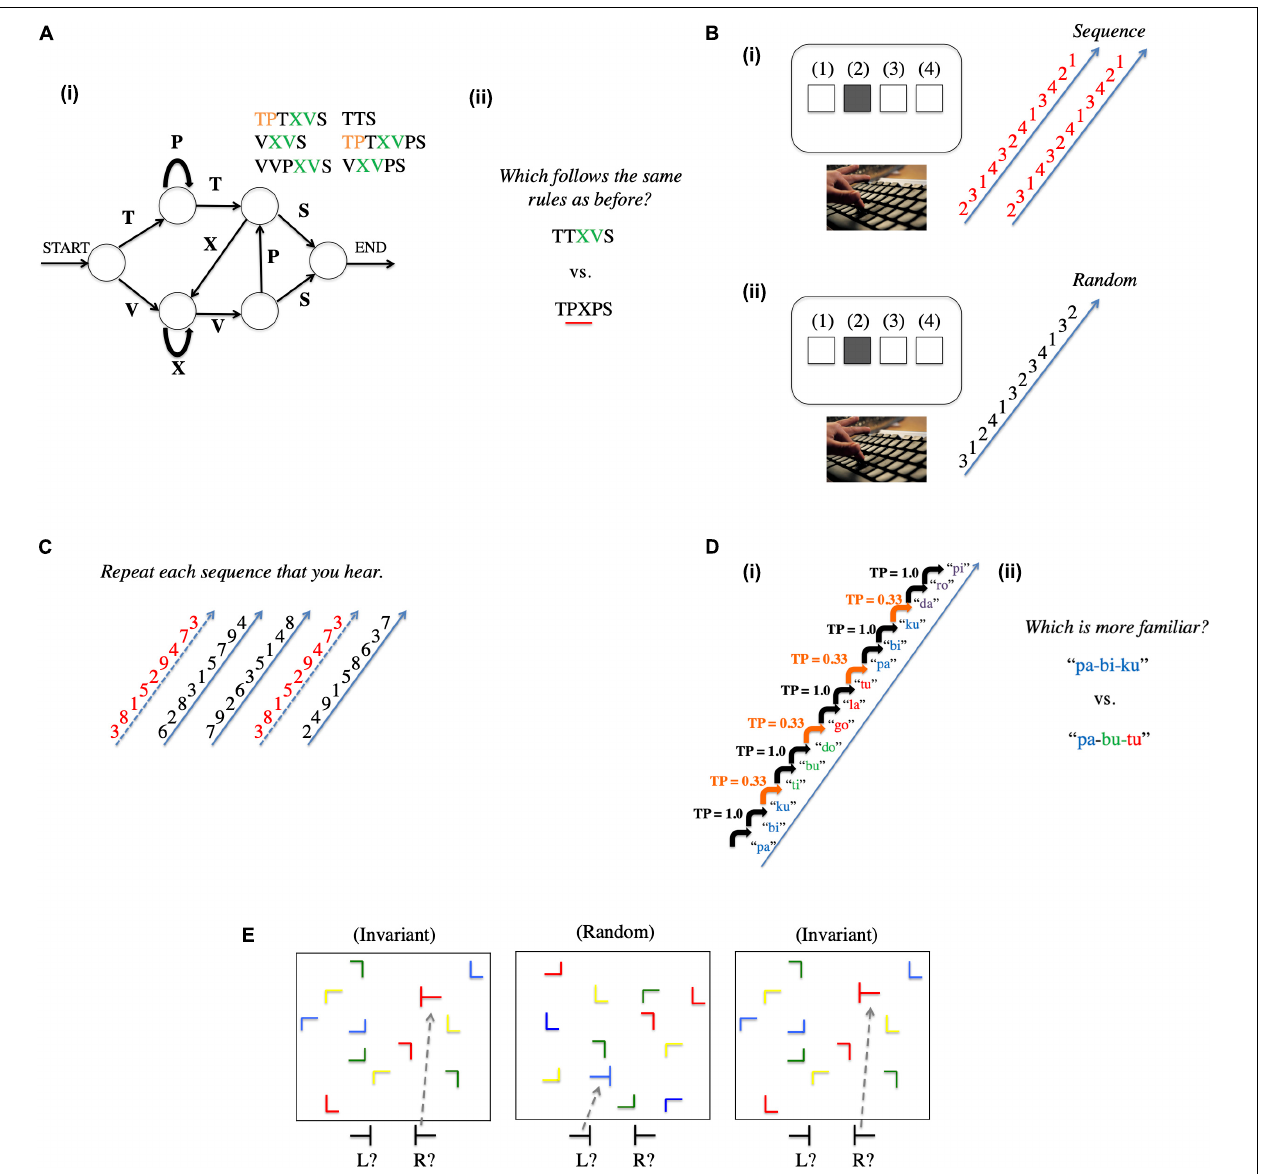
FIGURE 2 | Figure showing frequently used statistical learning tasks. (A) Artificial grammar learning task (Reber, 1967). (i) In this paradigm, participants are exposed to stimulus sequences generated from an artificial grammar that dictates the order that particular stimuli can occur in the sequence. (ii) Following exposure, participants make grammaticality judgments on novel sequences that either are produced by the same grammar or contain violations of the grammatical rules. (B) Serial reaction time task (Nissen and Bullemer, 1987). (i) In this paradigm, participants view stimuli occurring in one of four locations; on each trial, they are instructed to press a button corresponding to that particular location as quickly as possible. The stimuli appear in a sequence that repeats itself. (ii) Learning is assessed by comparing reaction times to the repeating sequence compared to stimuli that appear in random order. (C) Hebb repetition task (Hebb, 1961). Participants are presented with a sequence of stimuli and must repeat back the sequence in the correct order. On some trials, the sequence is random (solid arrows) and on other trials the sequence is a repetition (dashed arrows) from a previous sequence. Learning is assessed by comparing immediate serial recall for the repeating sequence compared to random sequences. (D) Embedded pattern (originally called word segmentation or triplet ) task (Saffran et al., 1996). (i) In the typical version of this paradigm, participants are provided with passive exposure to stimuli that conform to 3-syllable “words”; (ii) Following familiarization, participants are given a two-alternative forced-choice test, judging which of two 3-syllable sequences are “familiar.” Sequences can only be distinguished based on differences in transitional probabilities among the syllables (i.e., whether they conform to the “words” presented in the familiarization stream). (E) Contextual cueing task (Chun and Jiang, 1998). On each trial, participants view a scene with different colored visual stimuli arranged on the screen and must press one of two buttons as quickly as possible to indicate whether a target stimulus (in this case a “T” on its side) is pointed to the left or right. On some trials, the background stimuli occur in the same invariant arrangement, and on other trials, the background stimuli are presented in random arrangements. Learning is assessed by quicker responses to targets in the invariant scenes compared to random scenes (adapted from Arciuli and Conway, 2018).